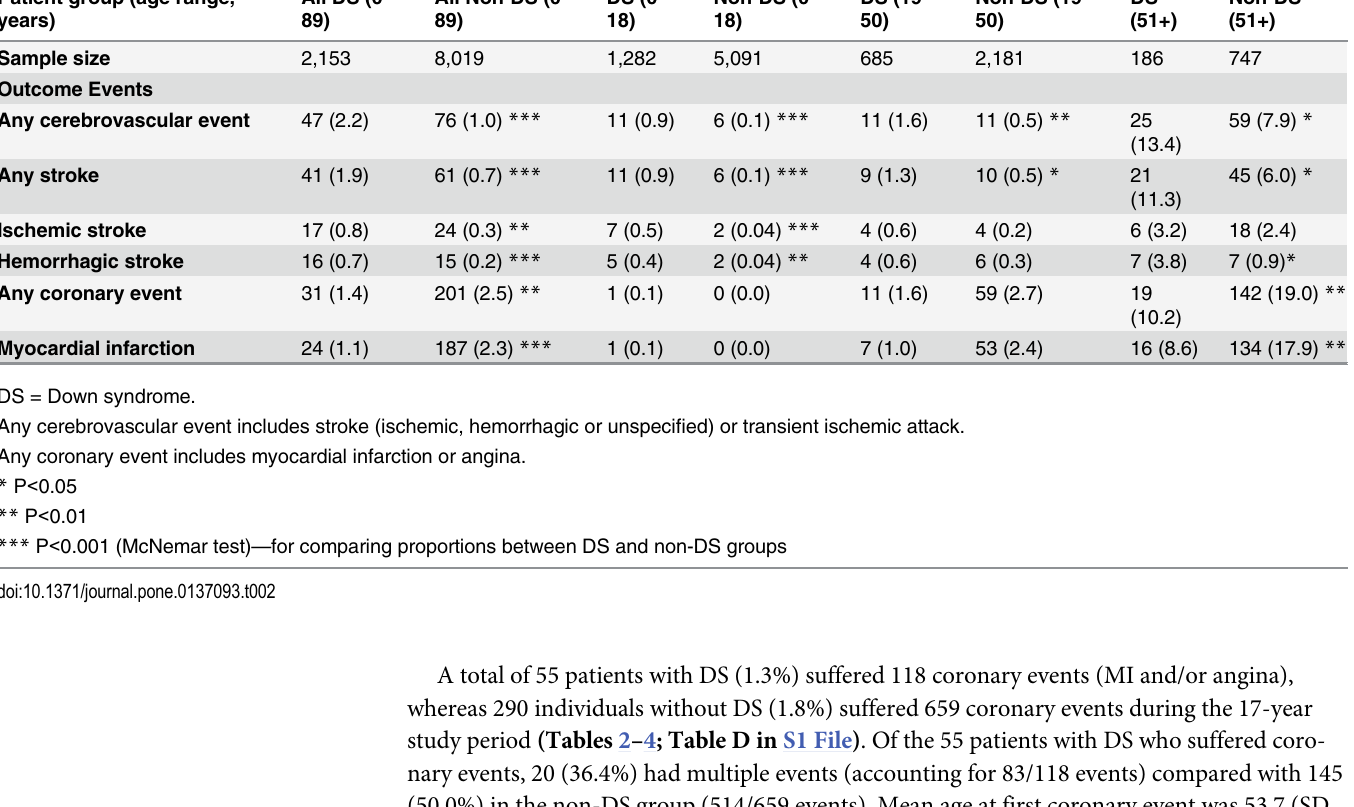
Table 2. Major cardiovascular events in males. (Data are n [%] patients unless indicated otherwise). Patient group (age range, years)